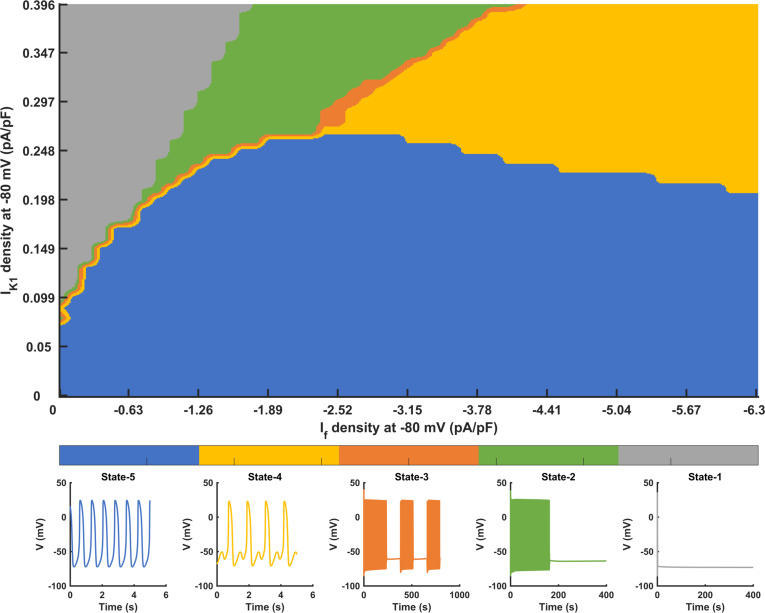
Dynamic behaviours of pacemaking action potentials in IK1/If parameter space.Blue: stable pacemaking activity (State-5); Yellow: persistent pacemaking activity with periodic incomplete depolarization (State-4). Orange: bursting pacemaking behaviour (State-3). Green: transient spontaneous pacemaking behaviour (State-2). Gray: no spontaneous pacemaking behaviour (State-1). In each category, the typical pacemaking action potentials are illustrated at the bottom panel.